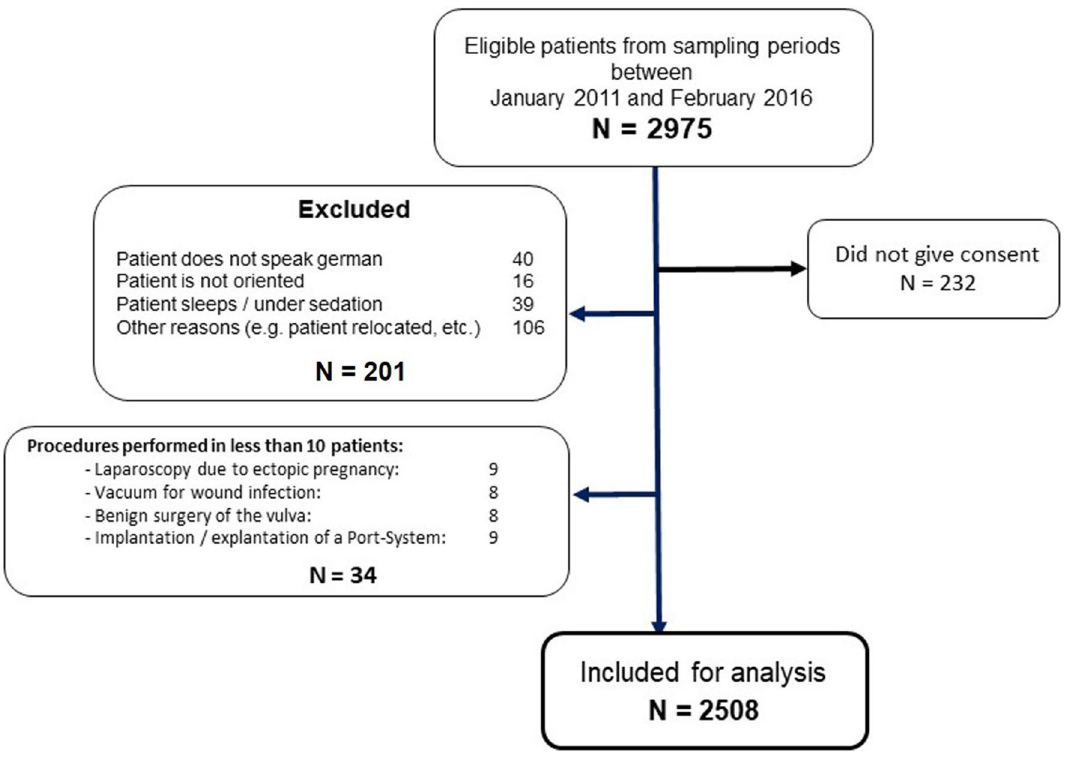
Figure 1. Patient inclusion